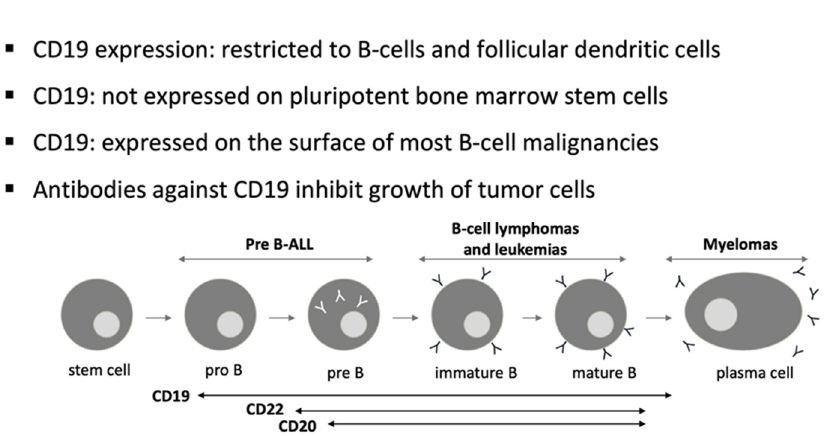
Figure 1. CD19: target for immunotherapy against B-cell ALL.